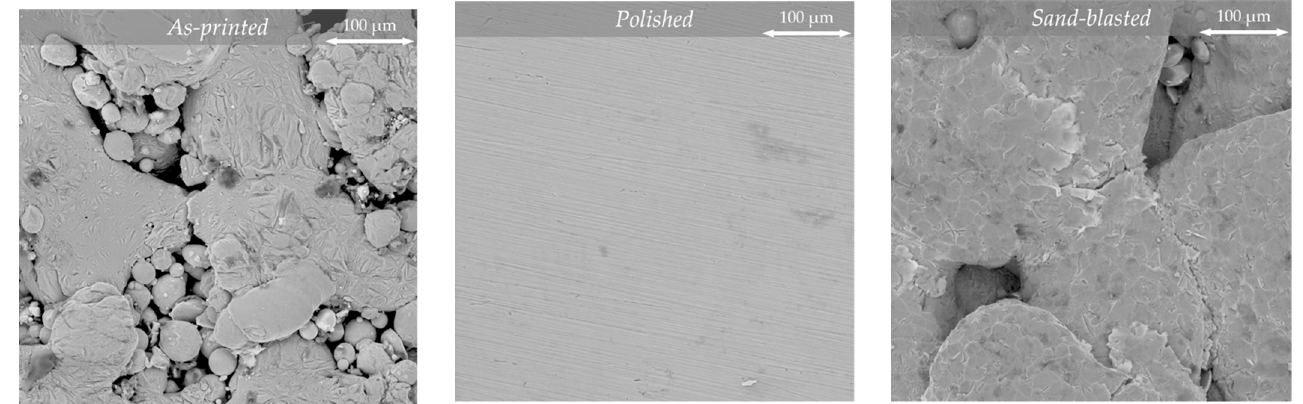
Figure 1. General appearance of as-printed, polished, and sand-blasted samples.